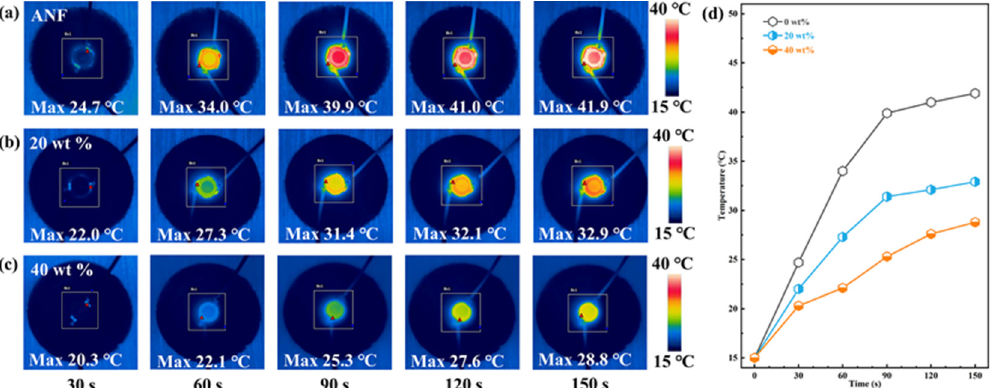
Figure 7. ( a – c ) Infrared thermal images of thermal distribution of the ANF/BNNS@Ag films with various filler contents under LED heat. ( d ) The curves of surface temperature variation of the ANF/BNNS@Ag films with various filler contents as a function of time upon heating.